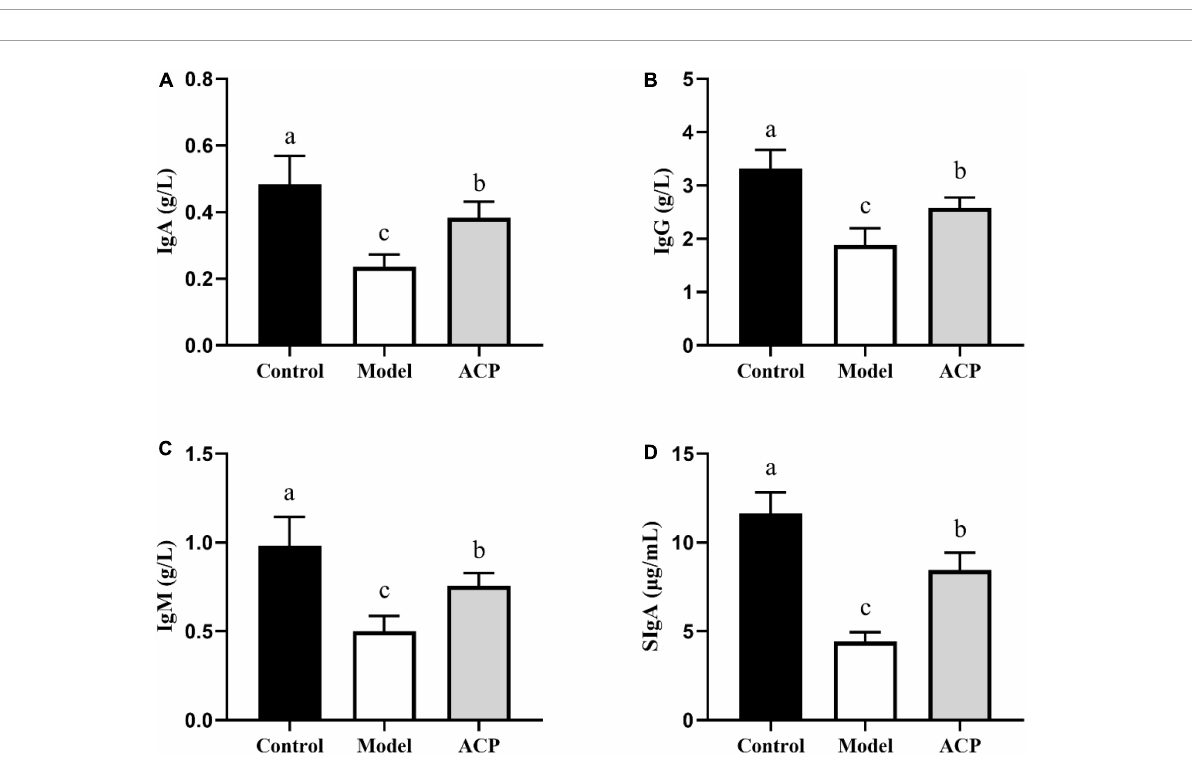
FIGURE2 Effect of Auricularia cornea var. Li. polysaccharides (ACP) supplementation on immunoglobulin contents in immunosuppressed mice. (A) IgA, (B) IgM, (C) IgG, and (D) sIgA. Values are mean ± SD ( n = 6 independent experiment). Different superscript letters indicate significant differences ( P < 0.05) by using one-way analysis of variance, followed by Duncan’s